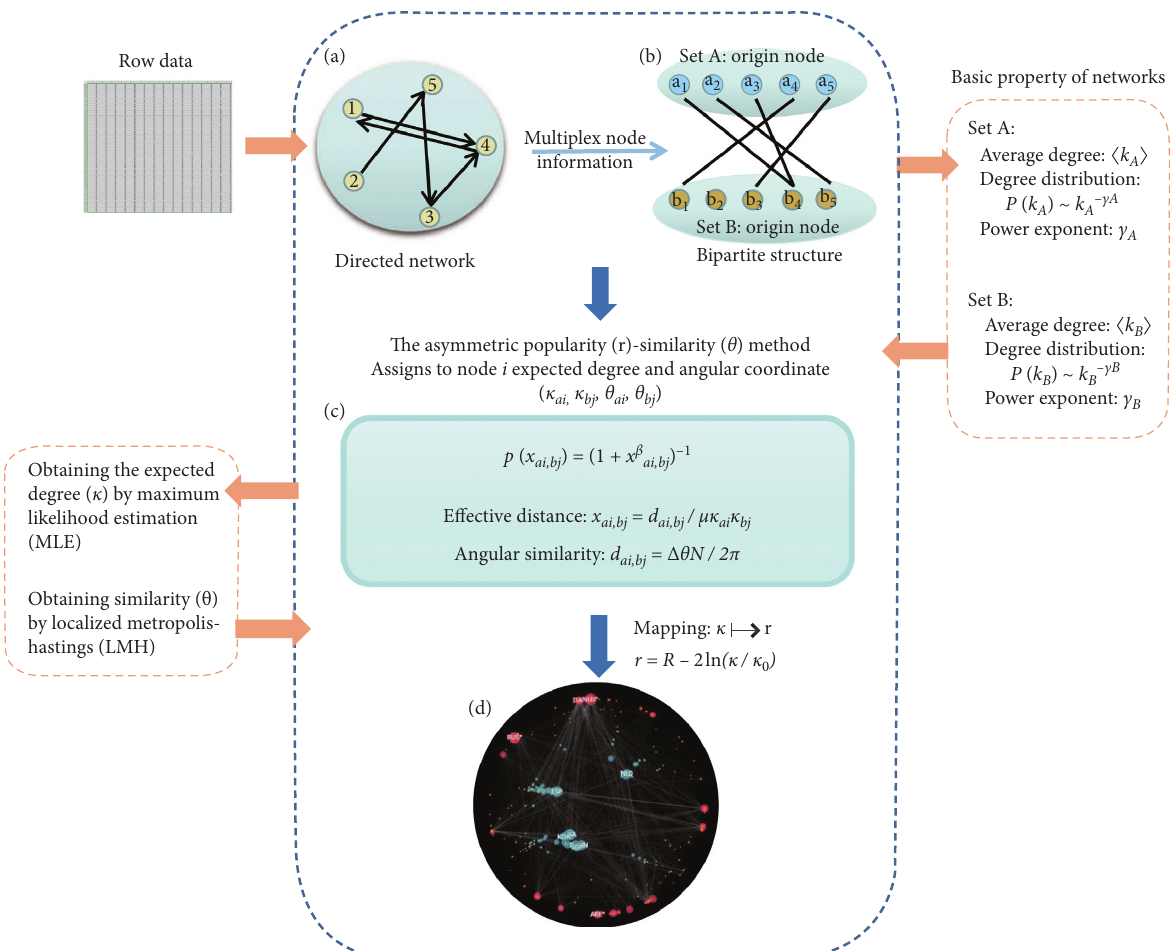
Figure 1: Flow diagram of the directed network embedding algorithm. The algorithm steps and intermediate input/output are illustrated. (a, b) An illustration of transforming directed networks (a) to directed networks with a bipartite structure (b). Specifically, an asymmetric link in (a) can be expressed as a link between any pair of nodes from set A and set B in (b). (c) The main principle of our embedding method. The hidden metric model with the asymmetric popularity-similarity method is used to construct the embedding process, where the estimation and optimization methods (MLE and LMH) obtain the metric space coordinates of nodes. (d) The κ − r mapping achieves the representation and visualization of directed networks in the hyperbolic